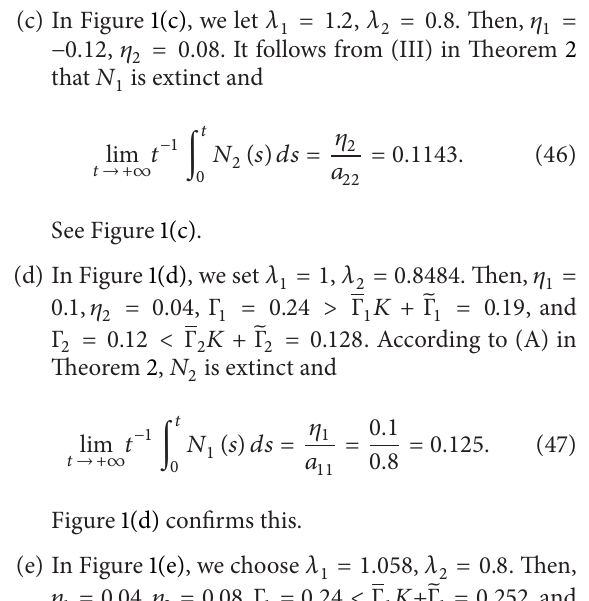
(0) = 𝐶 (0) = 0.1 , and step size Δ𝑡 = 0.001 . (a) is with 𝜆 0 𝑒 = 1 , 𝜆 = 0.8484 ; (e) is with 𝜆 1 2